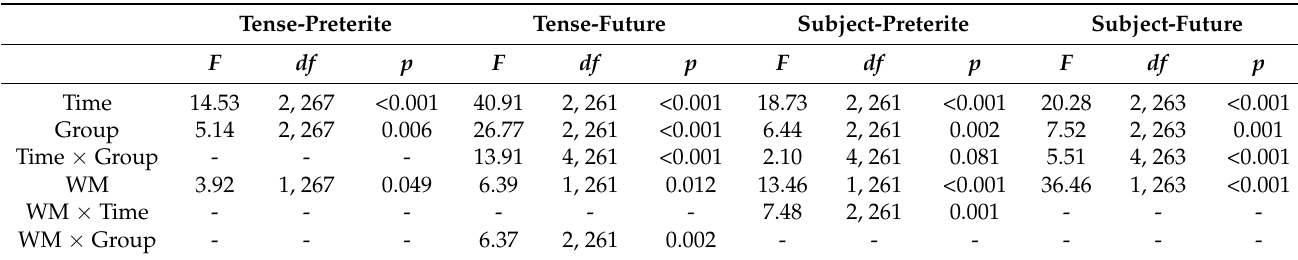
Table 6. Summary of Significant Main Effects in Interpretation Assessment Models.